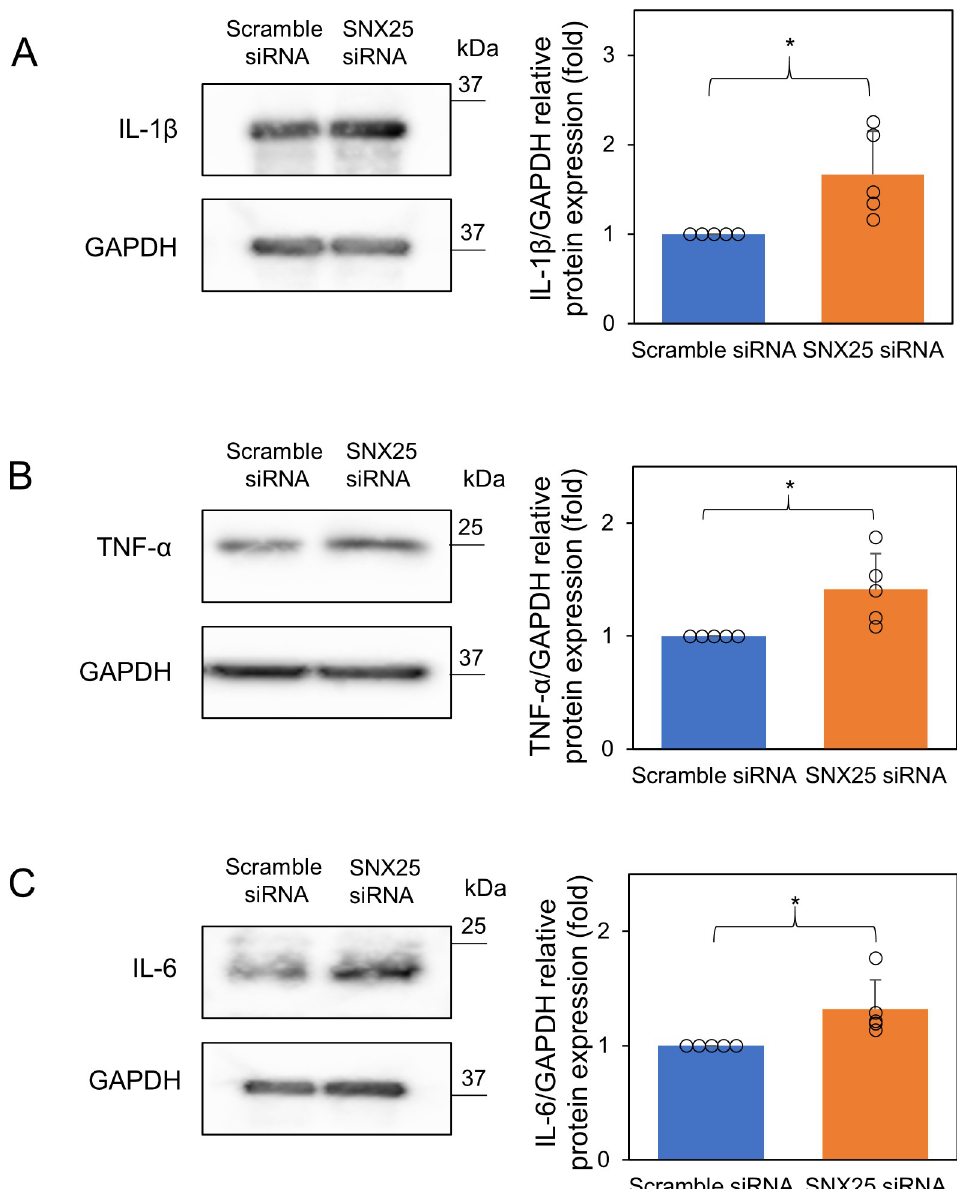
Fig 2. Relative protein expression of proinflammatory cytokines in SNX25 knockdown RAW 264.7 cells after LPS stimulation. (A–C) RAW 264.7 cells were stimulated with LPS (1 μ g/ml) for 12 h. The expression of IL-1 β , TNF- α , and IL-6 was analyzed by Western blotting. GAPDH was used as a loading control. Data are expressed as means ± SD. Circles indicate the individual experimental values. � P < 0.05, n = 5.